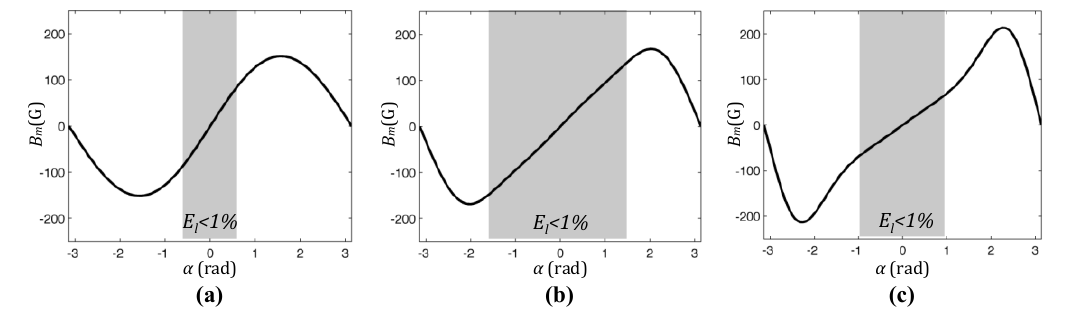
Figure 3. Estimated measured radial component of component versus angle. Plots